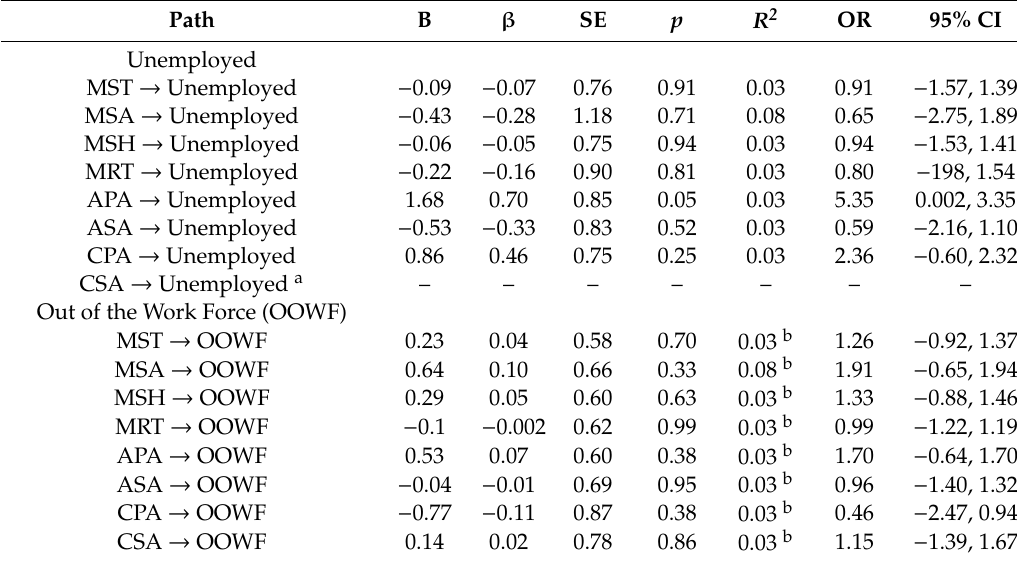
Table 2. Associations between trauma exposures and employment